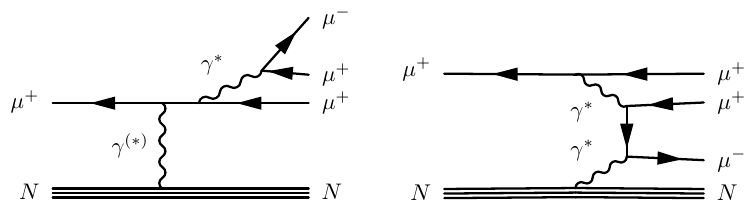
Figure 4. Feynman diagrams contributing to the SM muon trident